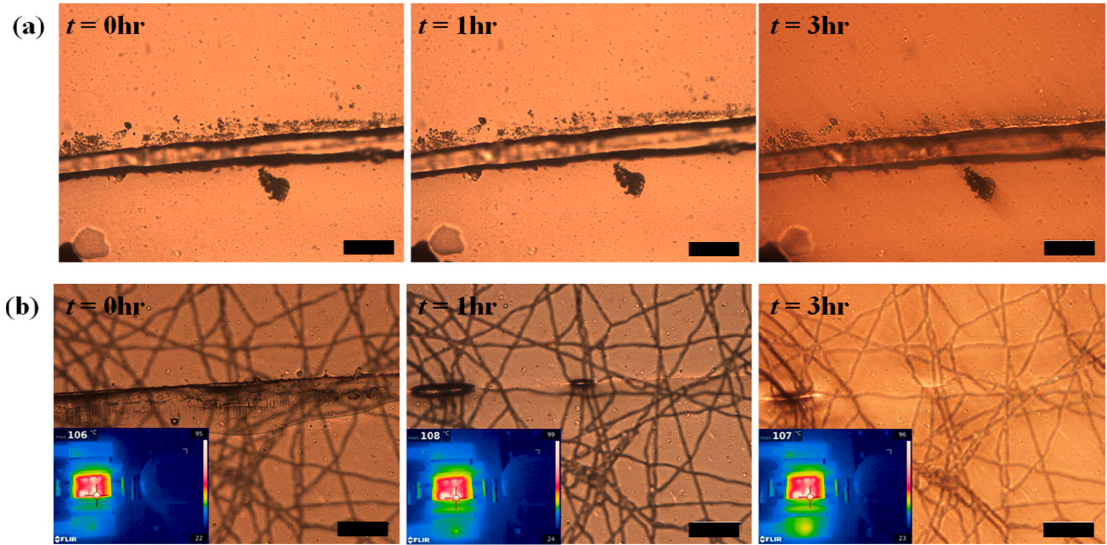
Figure 11. Optical images of the second crack on ( a ) the pristine plane substrate and ( b ) on the substrate heated with the CuNF heater. Scale bars are 100 mm [62]. Reproduced with permission from Lee, M.W; Applied Physics Letters; published by American Institute of Physics, 2017.